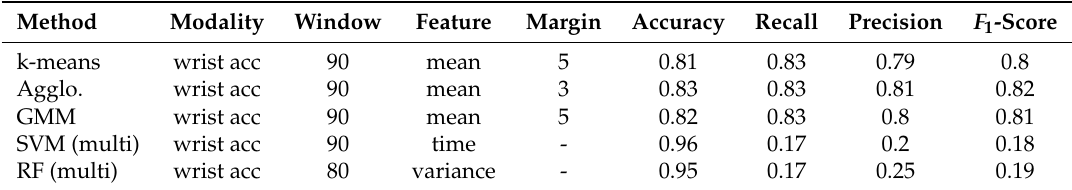
Table 5. Results for individual top experiment runs (by recall), for selected methods on the DNA extraction dataset, while not excluding NULL samples (the feature extraction window is the number of samples (@50Hz); the extracted feature is mean, variance or time (time = mean/var/range/median); the transition scoring margin is the number of